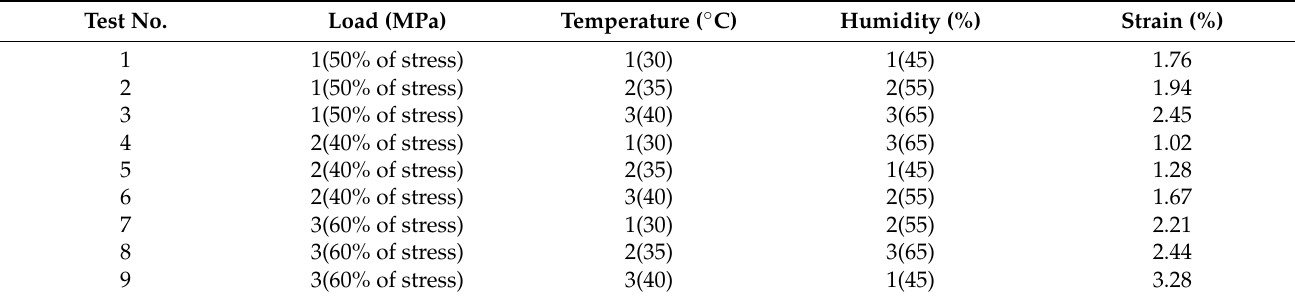
× f , as shown in L 2